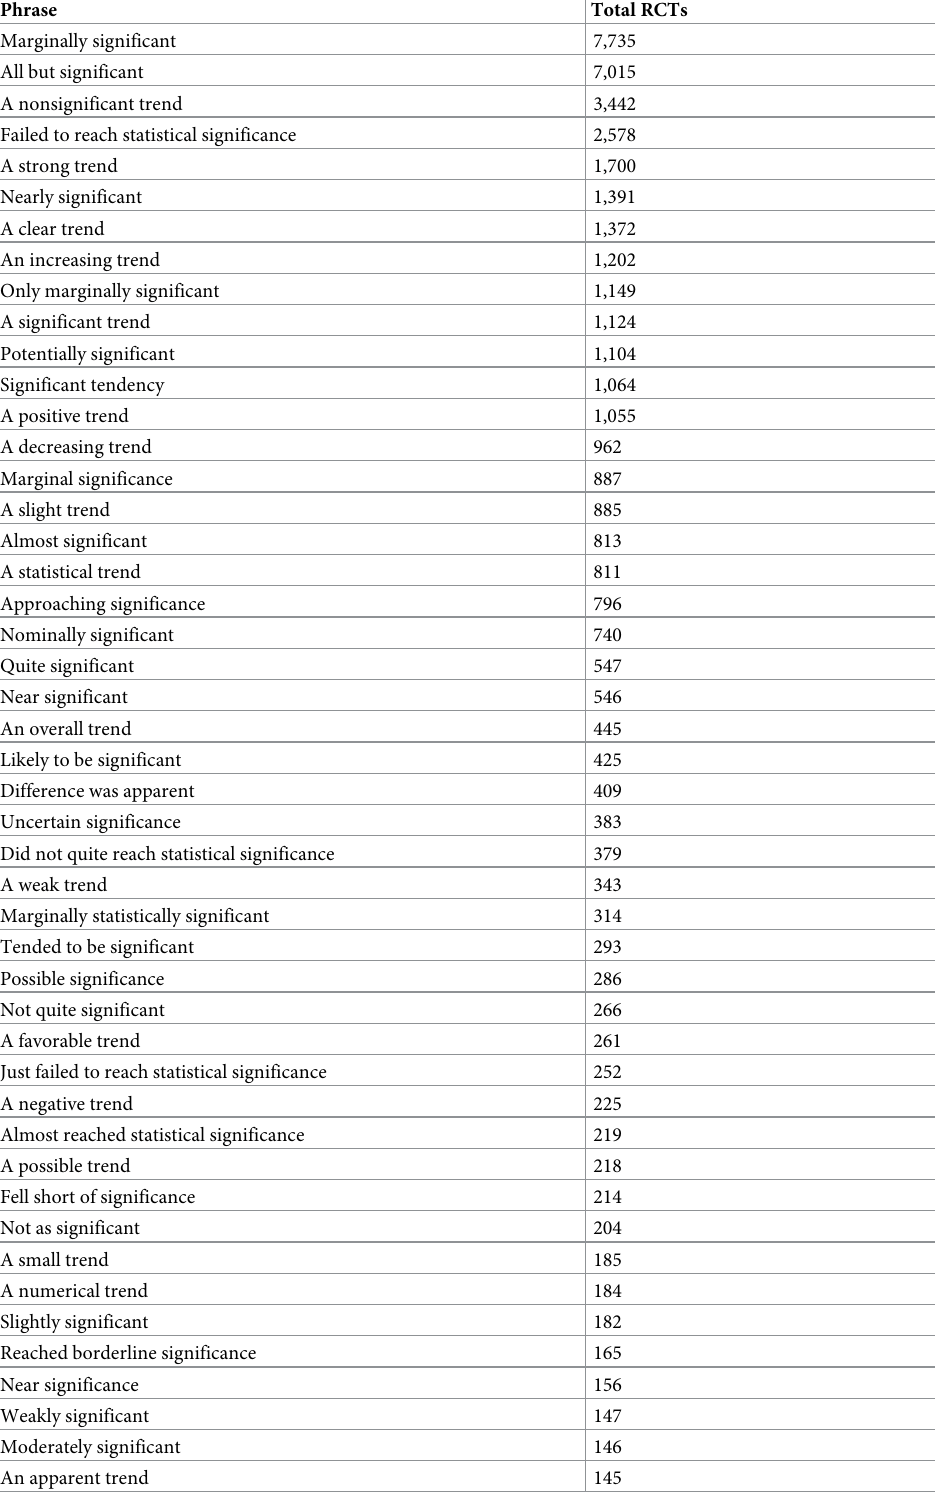
Table 1. The identified number of phrases (frequency n >